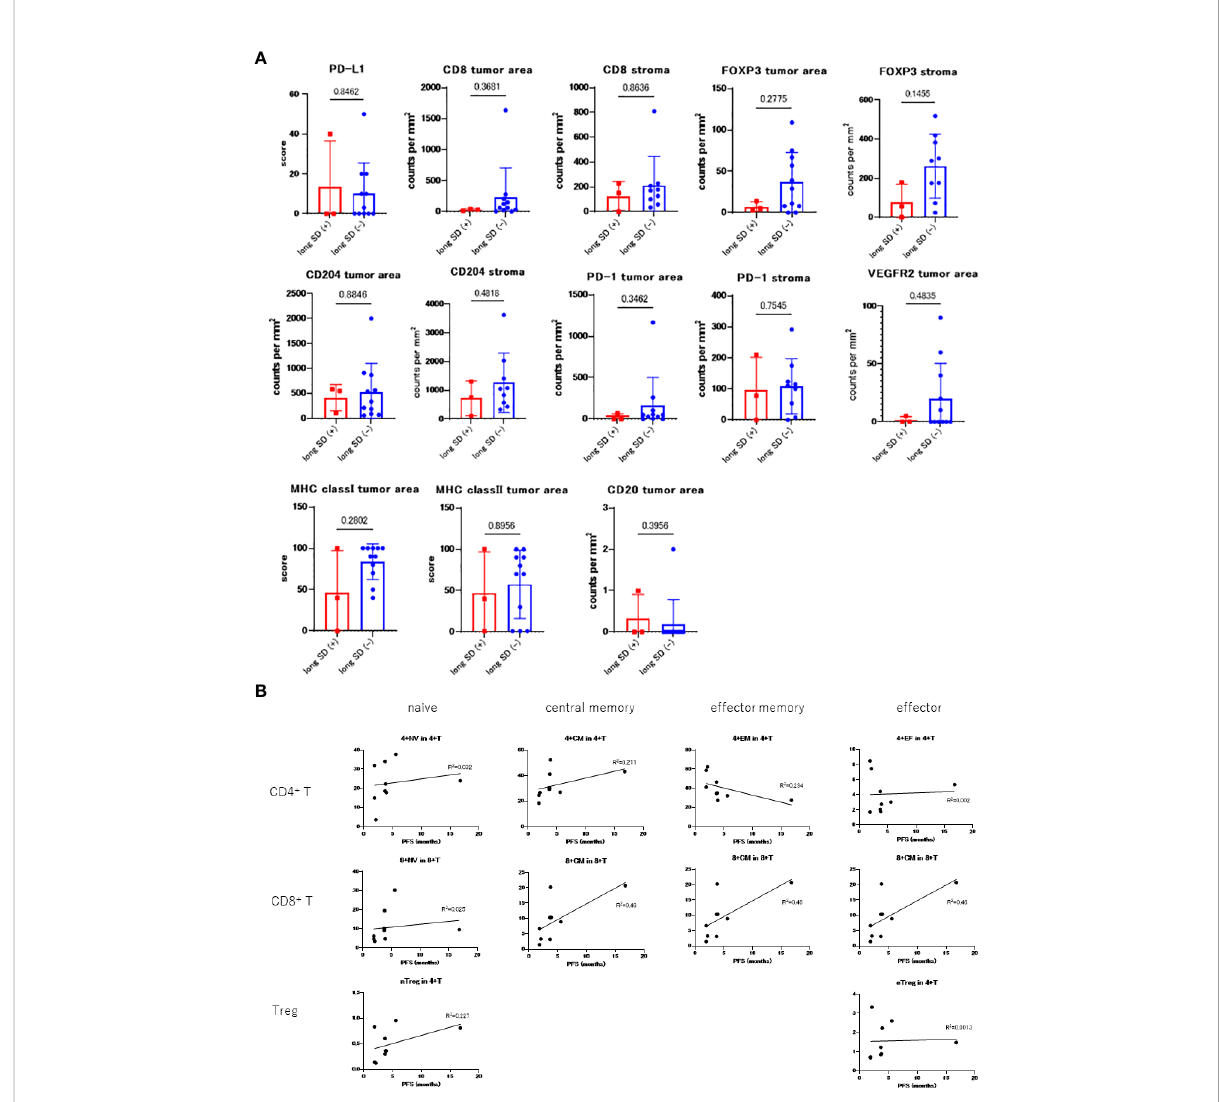
FIGURE 2 (A) Comparing the immunostaining scores between long SD (+) and long SD (-) groups. (B) PBMC count in each patient prior to treatment and correlation with